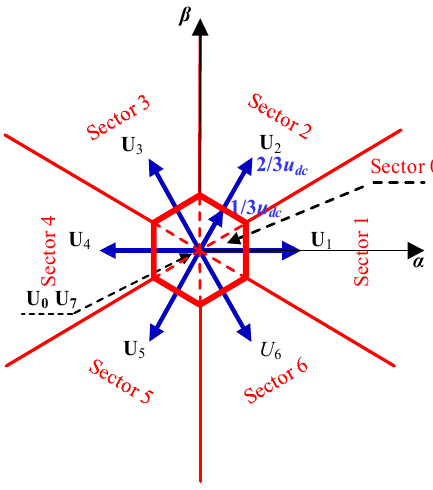
Figure 5. Distribution of the reference voltage vector.